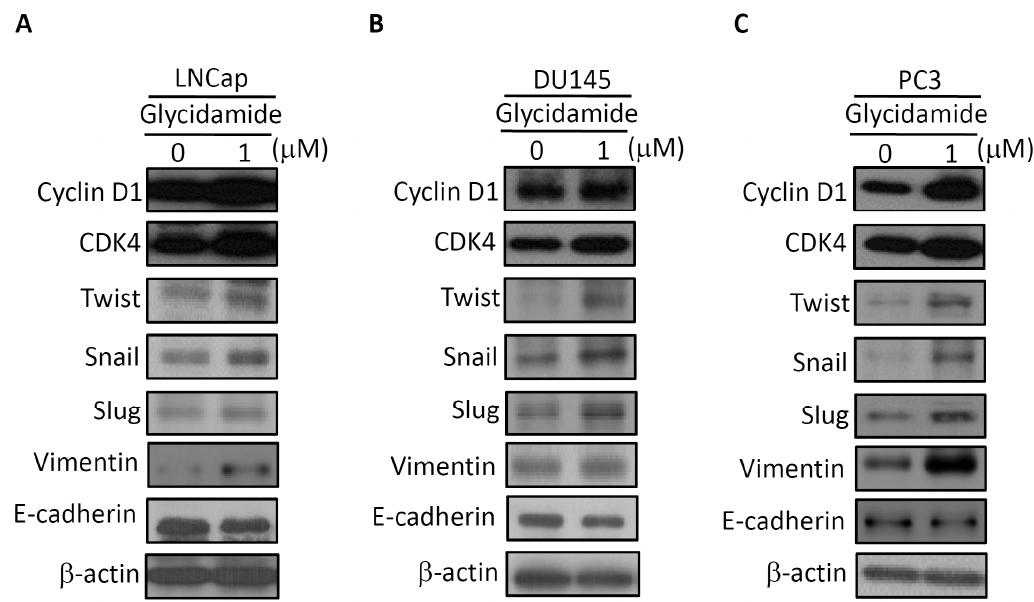
Figure 2. The effect of GA on protein expression of regulators of the cell cycle and epithelial-to-mesenchymal transition (EMT). LNCap ( A ), DU145 ( B ), and PC3 ( C ) cell lines were treated with GA at the indicated concentrations for 48 h. Cell extracts were analyzed by Western blotting with the antibodies of cyclin D1, CDK4, twist, snail, slug, vimentin, and E-cadherin, respectively. All experiments were performed in three independent experiments.